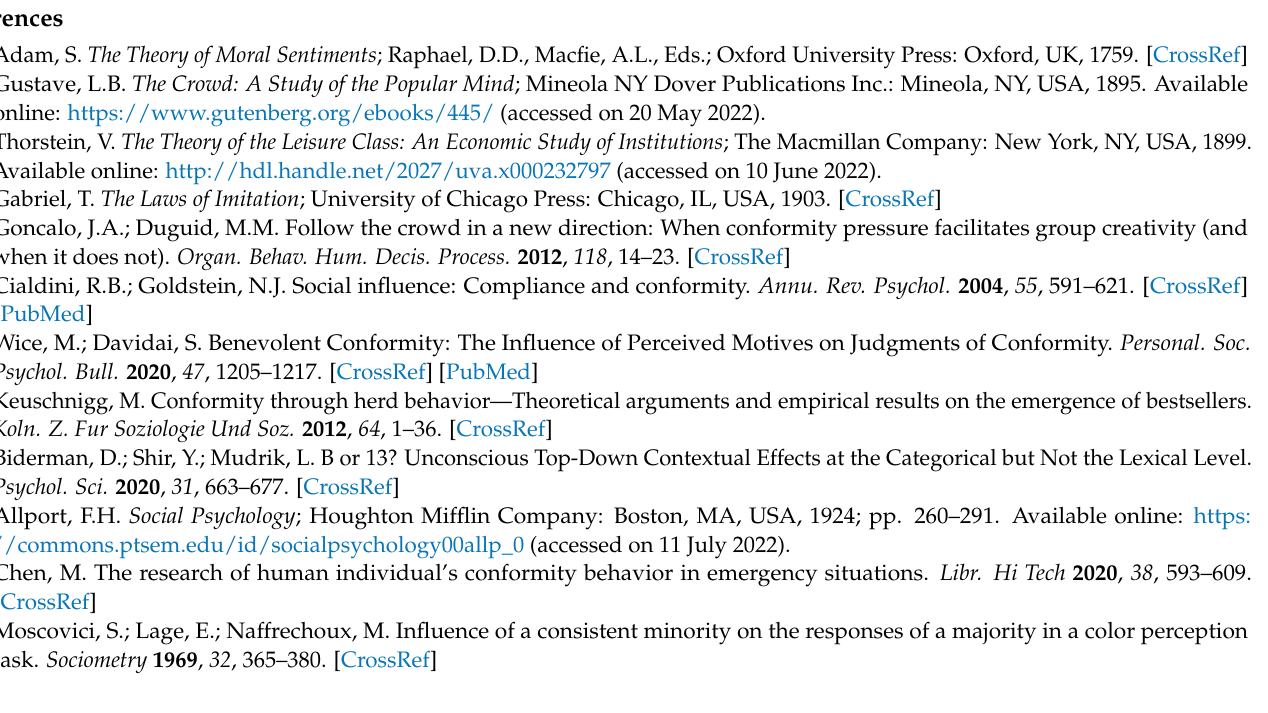
Table S2: The SRC incentives of the teachers interviewed; Figure S1: SRC type scree plot; Figure S2: SRC incentives scree plot; Table S3: Confirmatory factor analysis results of scientific research abidance; Table S4: Confirmatory factor analysis results for scientific research obedience; Table S5: Confirmatory factor analysis results of scientific research compliance; Table S6: Results of confirmatory factor analysis of internal incentives; Table S7: Results of confirmatory factor analysis of family incentives; Table S8: Results of confirmatory factor analysis of social relations incentives; Table S9: Results of confirmatory factor analysis of environmental incentives; Table S10: Results of confirmatory factor analysis of policy incentives; Table S11: Analysis of the half-reliability of the scientific research conformity scale; Table S12: Criteria for classification and classification of papers; Figure S3: The direct output of